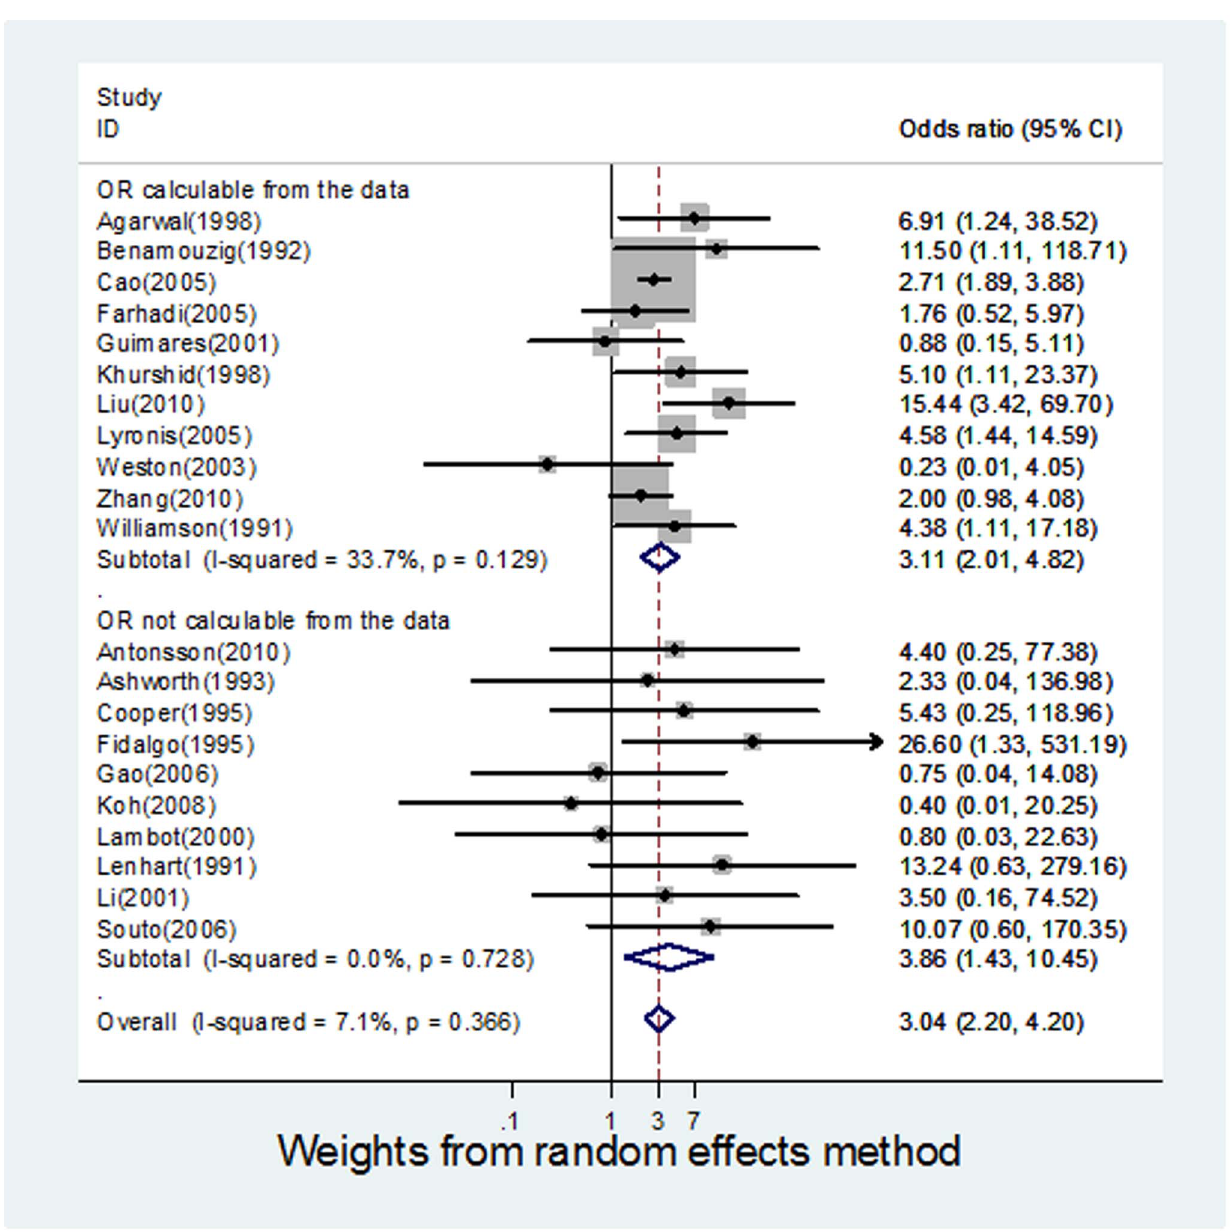
Figure 2. Forest plot for meta-analysis of the association of HPV with oesophageal squamous cell carcinoma in 21 case-control studies.